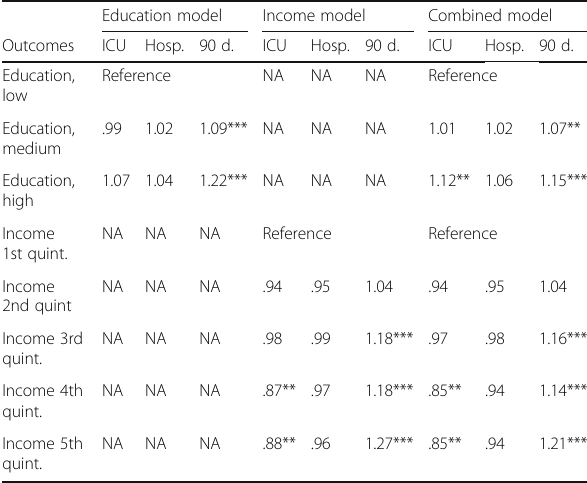
Table 1 (abstract 000224). Odds ratios (ORs) for the separate models and the combined model. All models were adjusted for age, gender, CCI and SAPS3 scores ** and *** denotes that ORs were significantly different from 1 (P<.01 and <.001, respectively). NA=not applicable Education model Income